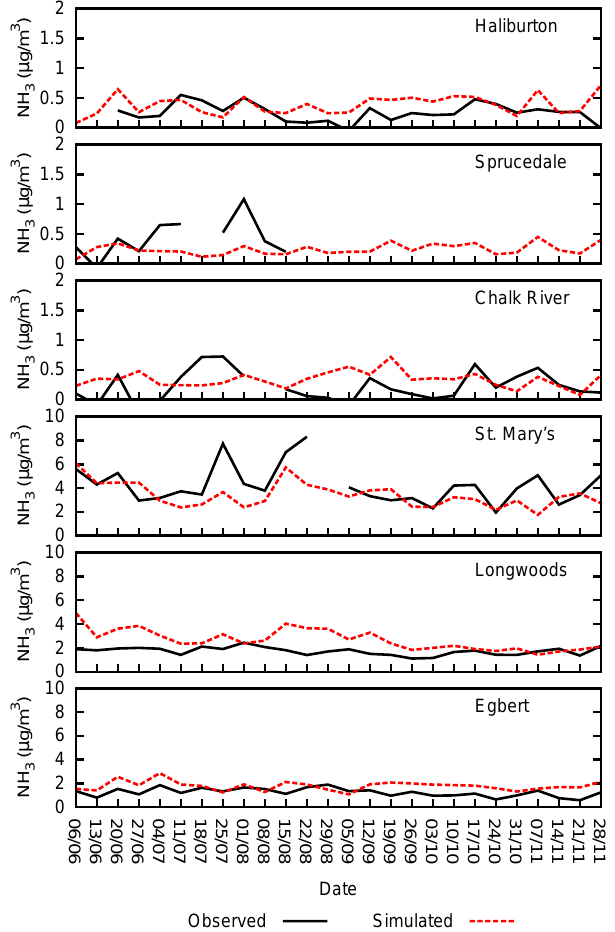
Fig. 3. Modeled (red dash) and measured (black solid) NH 3 con- centrations (µg m − 3 ) for each test site during the simulation period from 1 June to 30 November 2006. Note change in scale between upper and lower